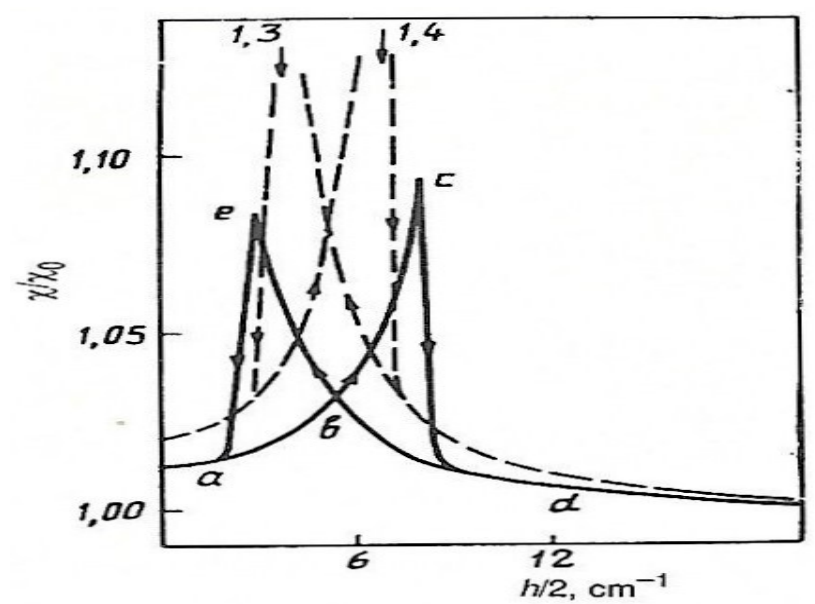
Figure 3. The dependence of the dielectric susceptibility of a DyVO 4 crystal upon the external magnetic field at the reorientation transitions for electric field E z = 0 (solid curves) and f χ 0 E z = 4 cm − 1 (dashed lines), f 2 = 2.1cm − 1 , A = 3.9cm − 1 , B = 7.2cm − 1 .